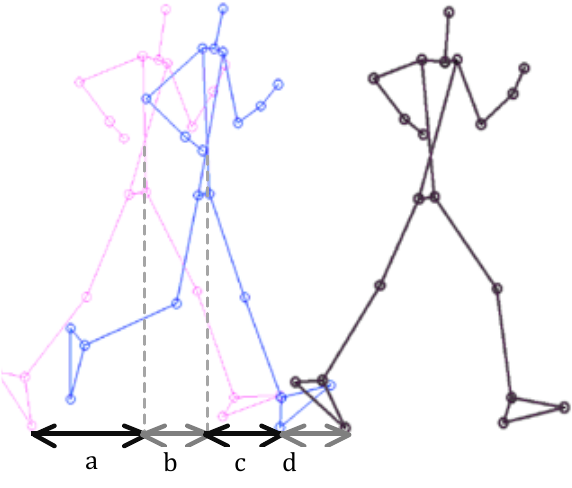
d Fig. 1. Characteristics of stride length constituents in race walking: а - rear stride; b - flight distance; c - front stride; d - support transition (foot length)